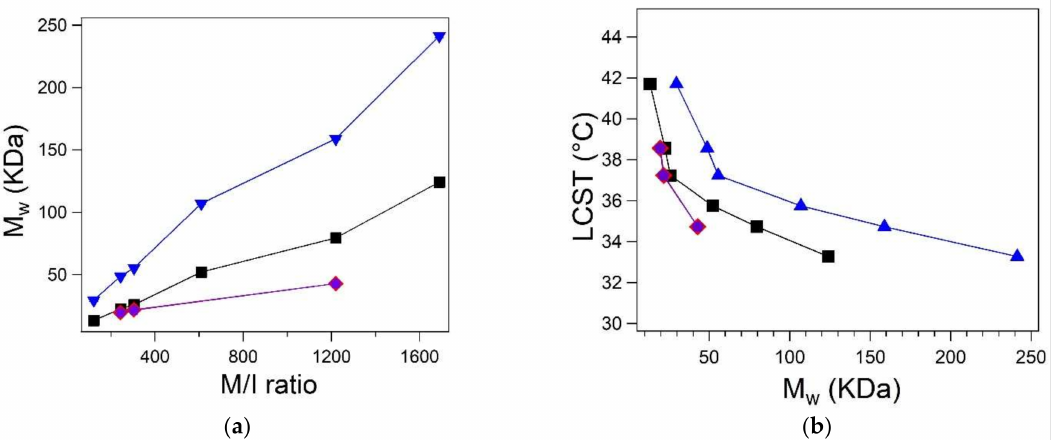
Figure 5. ( a ) Average molecular weight as a function of M/I ratio. ( b ) Spectroscopic LCST reported as a function of the average molecular weight. The graphics show the comparison between the values calculated using the models reported by Lau (black), Eisele (blue), and viscosimetric masses calculated using Equations (6) (red) and (7)